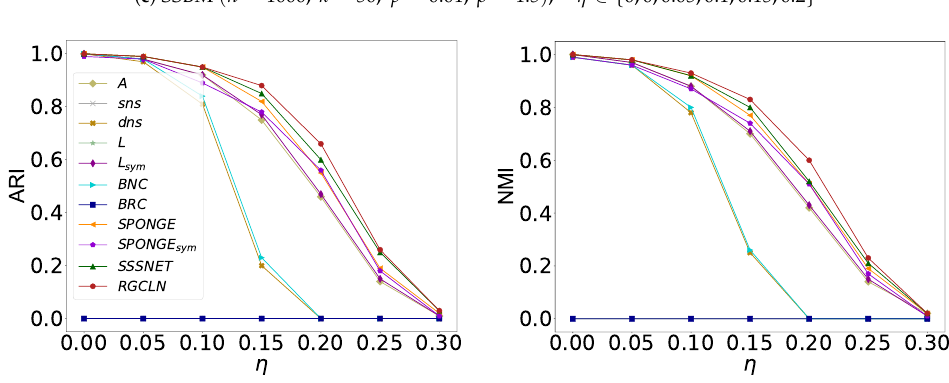
Figure 3. Stochastic block generation network with different sizes and different parameter